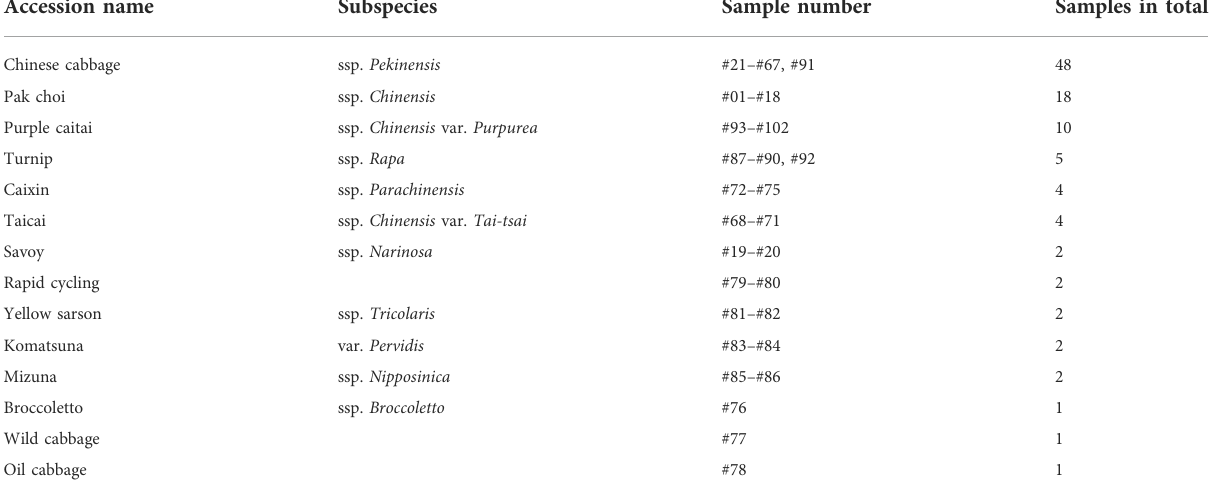
TABLE 1 Summary of the 102 B. rapa accessions in this